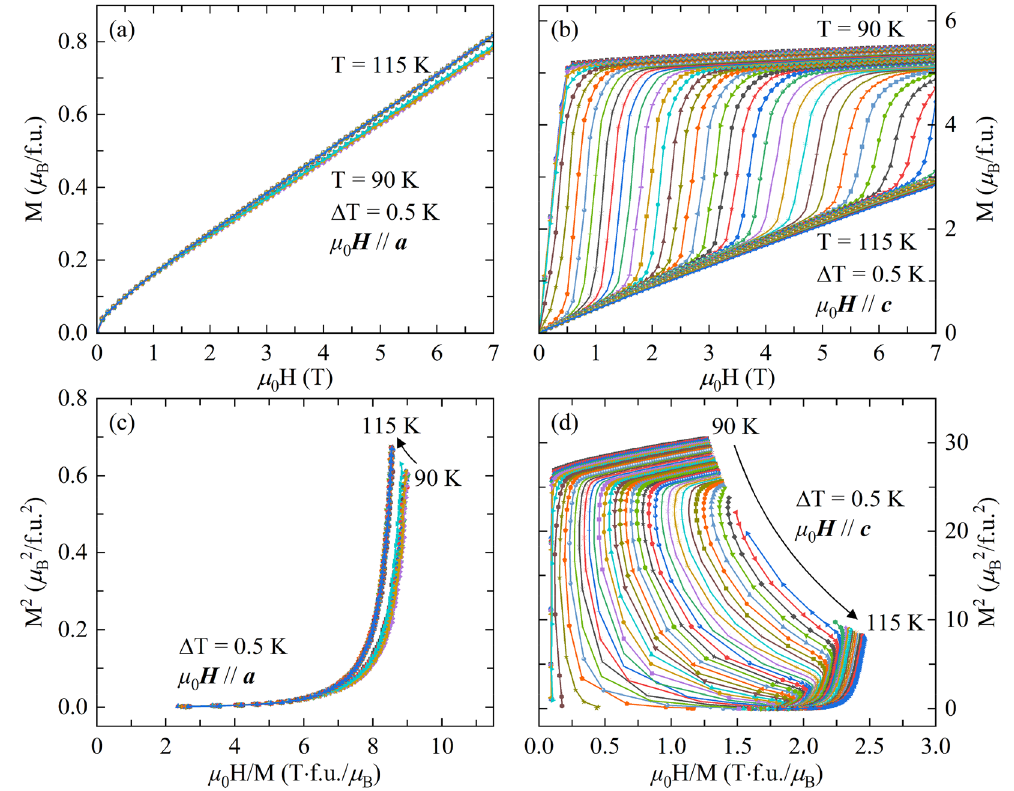
Figure 3. Isothermal initial magnetization curves in the temperature range from 90 to 115 K with an interval temperature of 0.5 K along ( a ) a and ( b ) c axes. ( c ) and ( d ) show the Arrott plot for magnetic field along a and c axes,